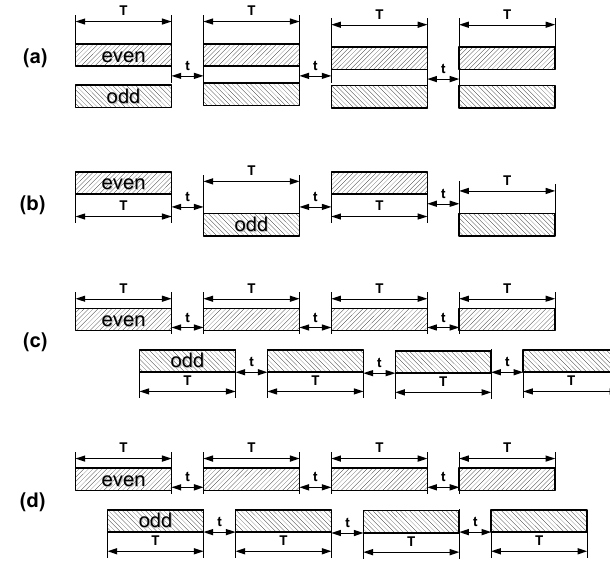
Figure A2. Timing for interlaced readout: (a) “fast mode” with combined simultaneous even and odd rows, (b) alternating nonoverlapping even/odd, (c) alternating overlapping offset, and (d) “pseudo-progressive” alternating minimal